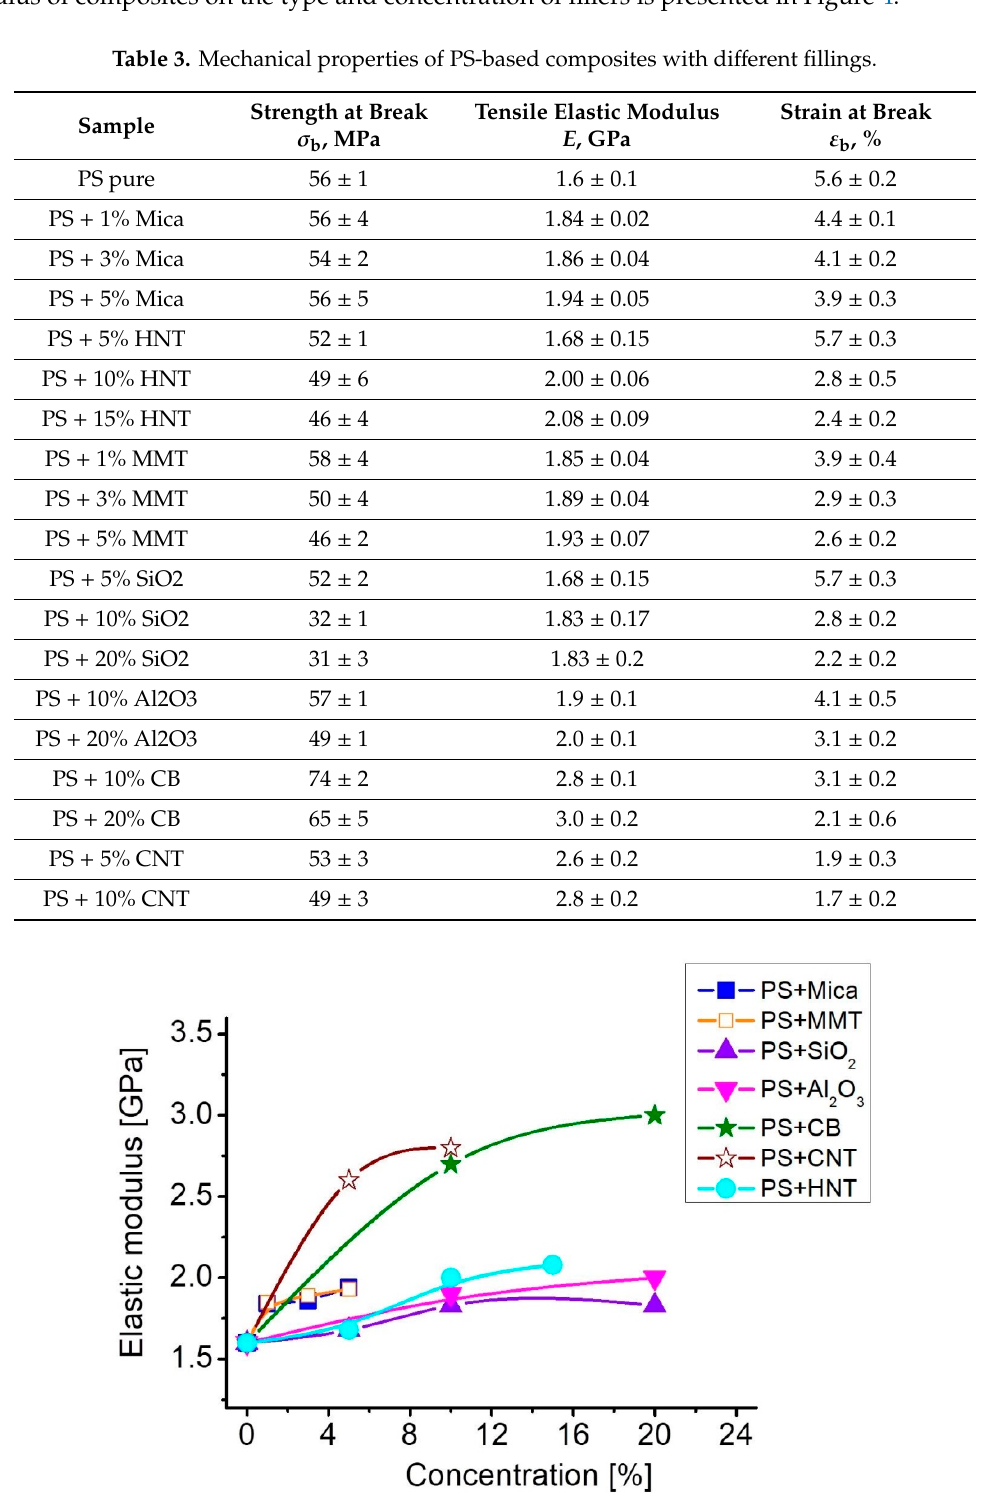
Figure 4. Elastic modulus of PS-based composites as function of filler concentration.